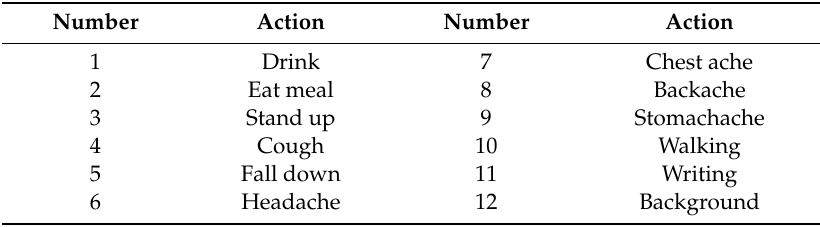
Table 1. Classes of action